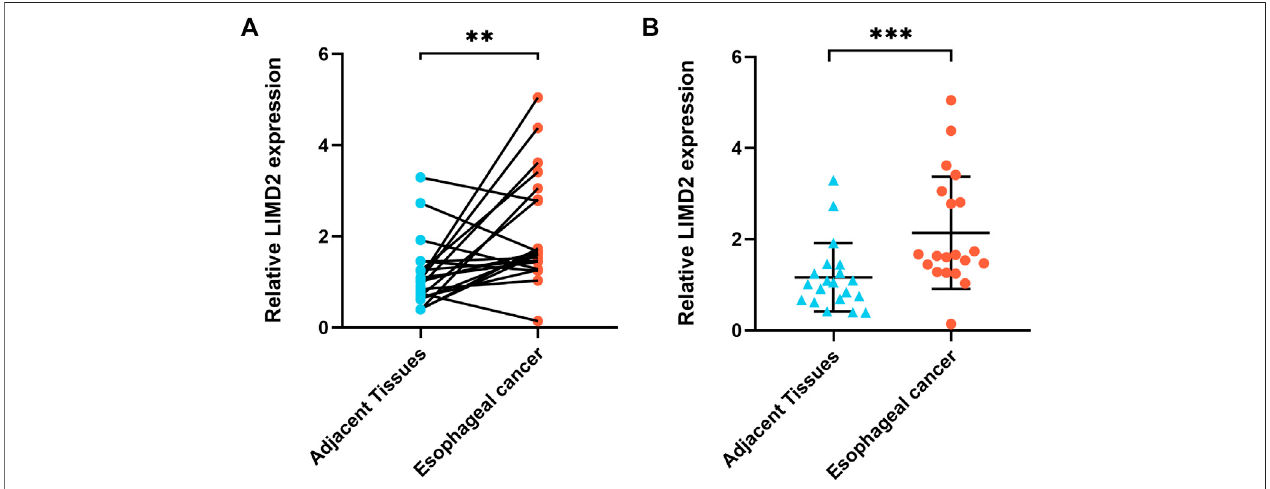
FIGURE 8 | Validationoftheexpressionoftarget LIMD2 . The LIMD2 expressioninECA( n (cid:1) 20) and adjacentnormaltissues ( n (cid:1) 20) was evaluated byqRT-PCR; the results were analyzed using the paired sample t- test (A) and Wilcoxon rank sum test (B) . Results expressed asmean ± standard deviation (SD). * p < 0.01 and ** p < 0.001.